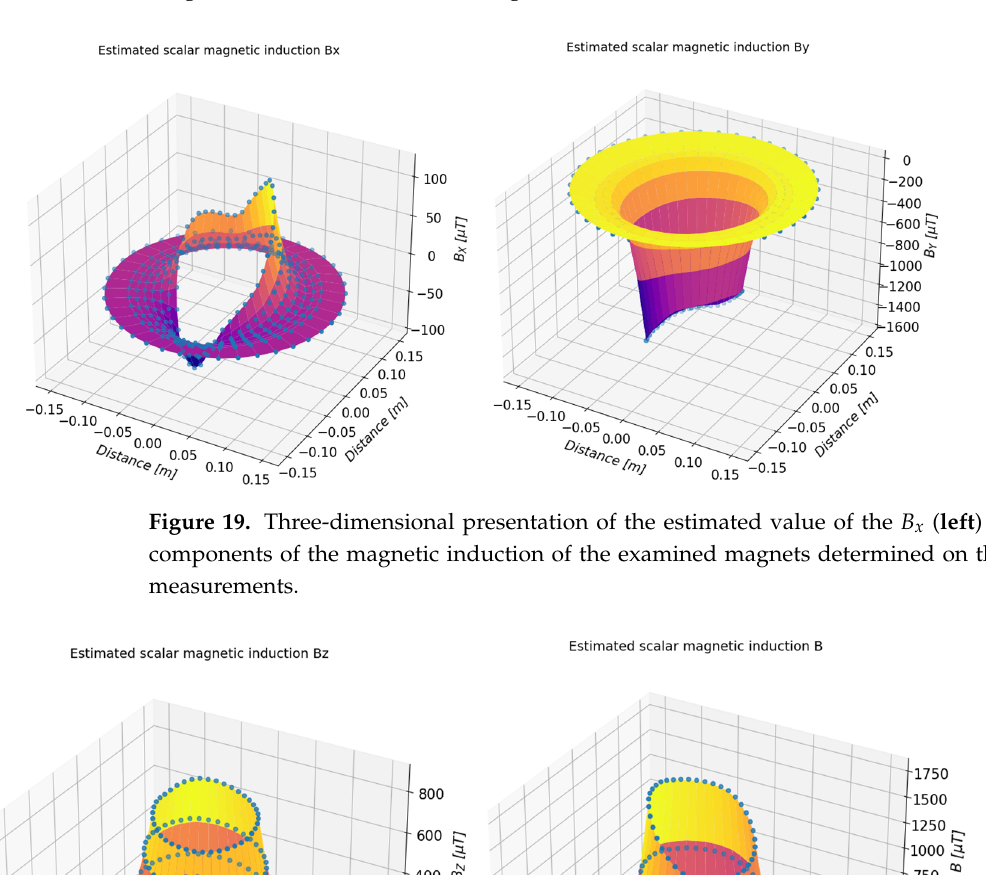
Figure 18. Comparison of the relative errors for the estimated values of the magnetic induction of the tested toroidal magnet depending on the measuring distance.